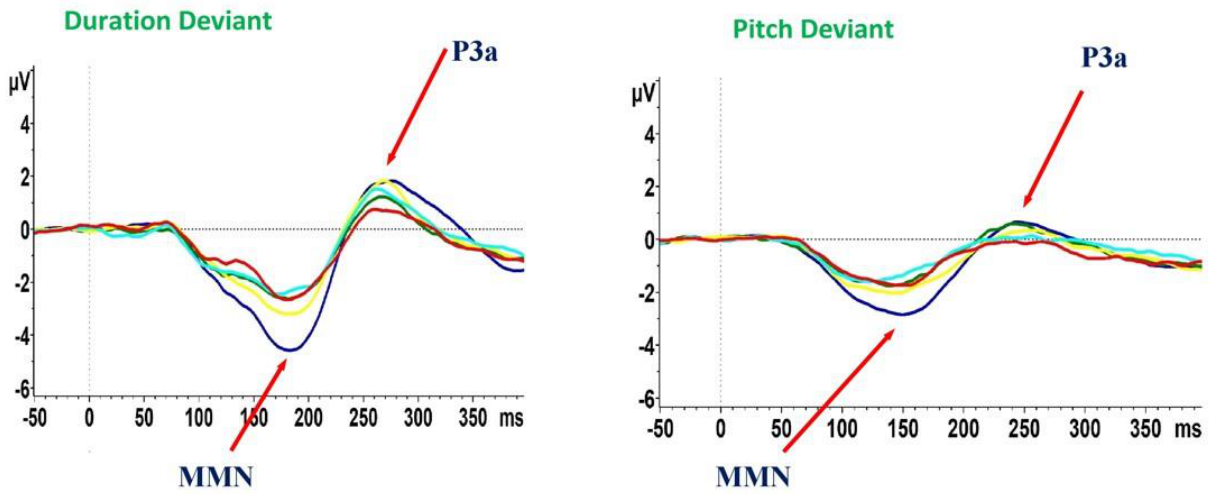
Figure 1. Mismatch negativity (MMN) and P3a waveforms recorded during the auditory paradigm in healthy controls and subjects with schizophrenia. HCs, healthy controls (blue line); SCZ, subjects with schizophrenia; ID, illness duration. SCZ-A, ID ≤ 5 (green line); SCZ-B, ID 6 to 13 years (yellow line); SCZ-C, ID 14 to 18 years (pale blue line); SCZ-D, ID 19 to 32 years (red line). Table 3. Group differences for MMN and P3a. Age and gender as